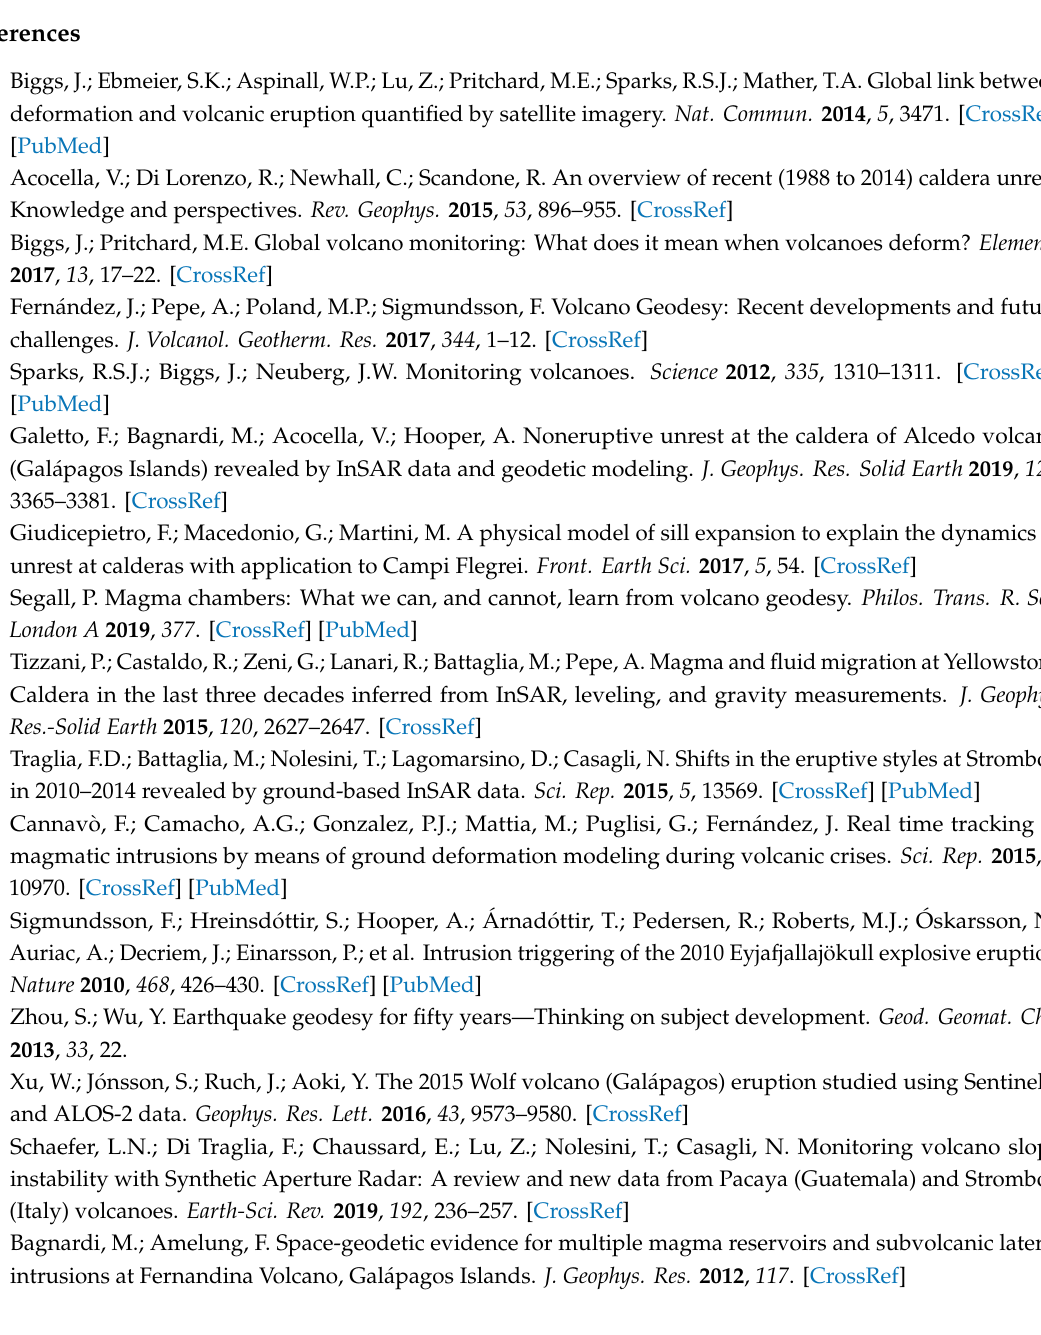
† Plane: orbit ramp corrected by a plane. ‡ Quadric Surface: orbit ramp corrected by a surface. § DEM: atmospheric delaying corrected by linear correlated with the digital elevation model (DEM). * GACOS: atmospheric delaying corrected by GACOS. †† Plane + DEM: orbit ramp corrected by a plane and atmospheric delaying corrected by linear correlated with the DEM. ‡‡ Plane + GACOS: orbit ramp corrected by a plane and atmospheric delaying corrected by